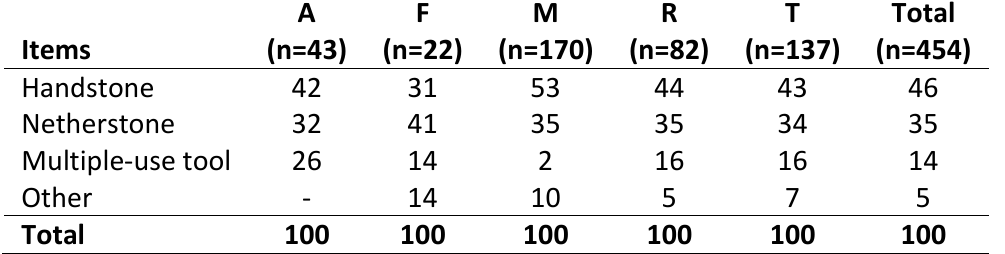
Table 2. Frequencies of summary ground stone tools categories by area. Chi Square = 19.406; Degrees of freedom = 12; p-value = 0.079. As the computed p-value is greater than the significance level alpha = 0.05, one cannot reject the null hypothesis H0: the rows and columns are independent.